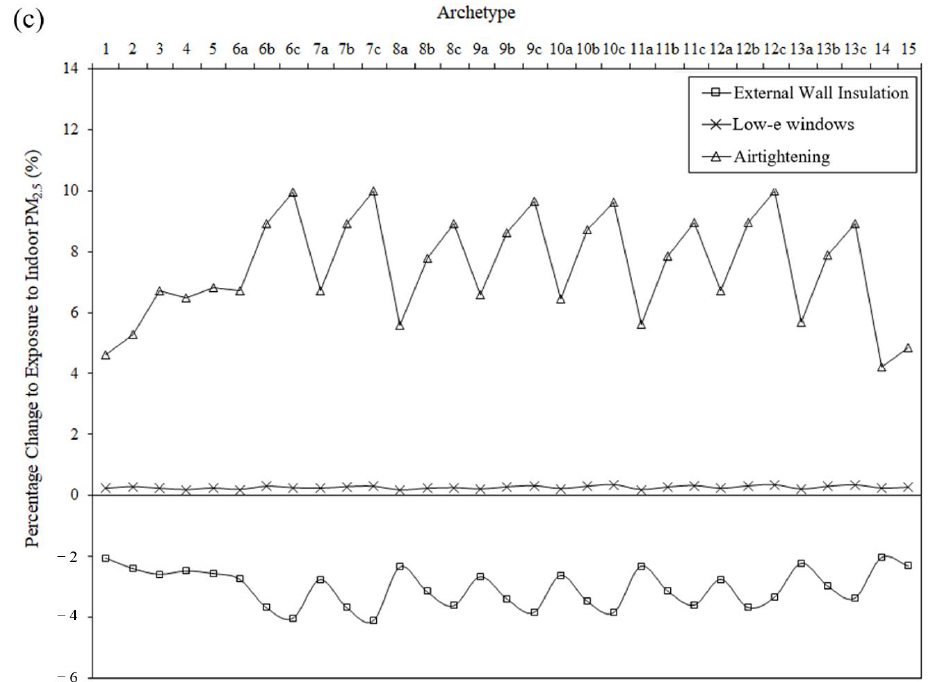
Figure 10. The percentage change to exposure to ( a ) PM 2.5 from outdoor sources; ( b ) PM 2.5 from indoor sources; and ( c ) indoor PM 2.5 caused by each fabric retrofit amongst the 15 archetypes (a: ground-floor flats, b: middle-floor flats, and c: top-floor flats), averaged over the pensioner and family results.